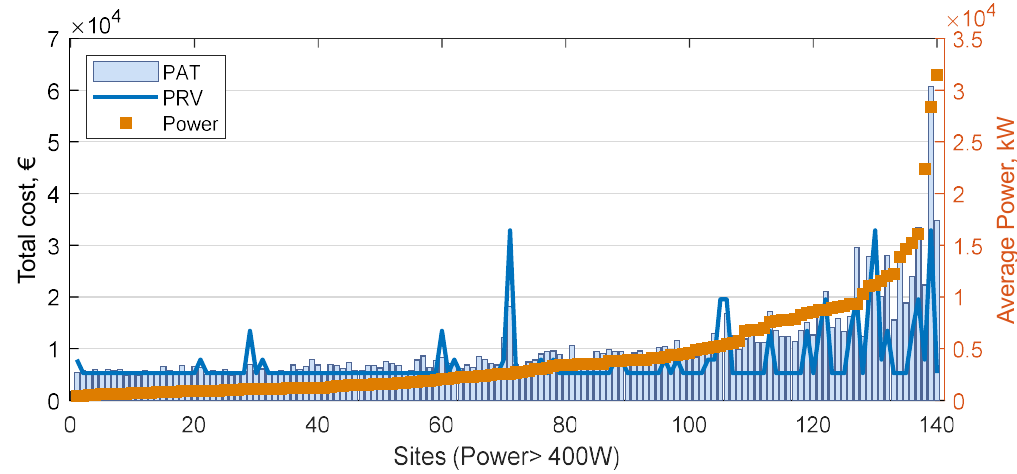
Figure 11. PAT vs. PRV total cost according to the average power at the evaluated sites.